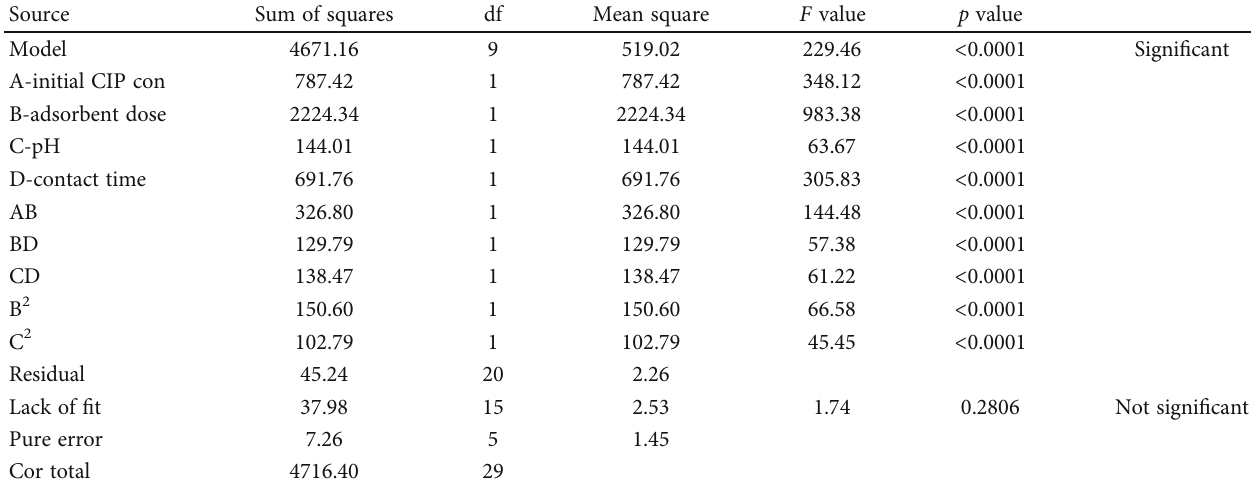
Table 3: ANOVA results of the CIP adsorption onto